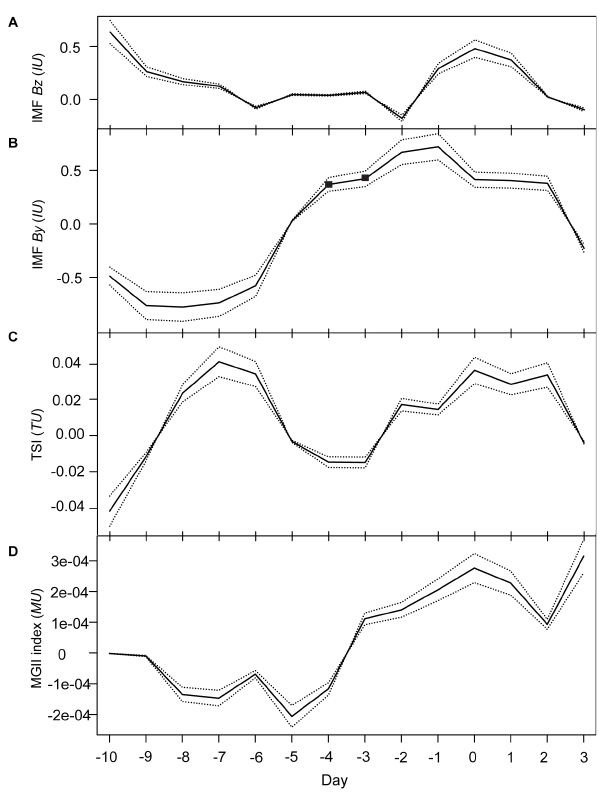
Fig. 4. Anomalous changes in the (A) IMF Bz (north-south) compo- nent, (B) IMF By (east-west) component, (IMF units in “ IU ”, denot- ing a change of 1n/T in four days] (C) Total Solar Irradiance (TSI) from the Active Cavity Radiometer Irradiance Monitor (ACRIM) reconstructions (units in “ TU ”, denoting a change of 1W/m 2 in four days) and (D) MG II UV index (units in “ MU ”, denoting a change of 1 unit in four days). Statistically significant anomalies indicated by markers, dotted line indicates 0.95 confidence